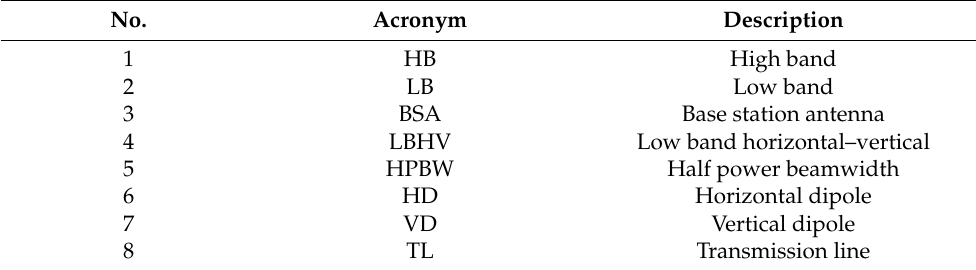
Figure 1. ( a ) Slant dipole configuration used in traditional interleaved scheme for dual-band dual- polarized BSA. ( b ) The proposed horizontal and vertical LB dipole configuration (LBHV) with HB subarrays. P1 and P3 refer to +45 polarizations; P2 and P4 refer to − 45 polarization. Table 1. List of Acronyms.